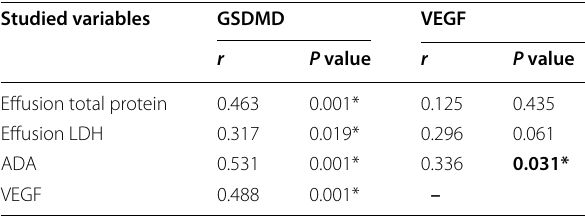
Table 3 Correlation between GSDMD and VEGF with laboratory investigations of exudative pleural effusion group